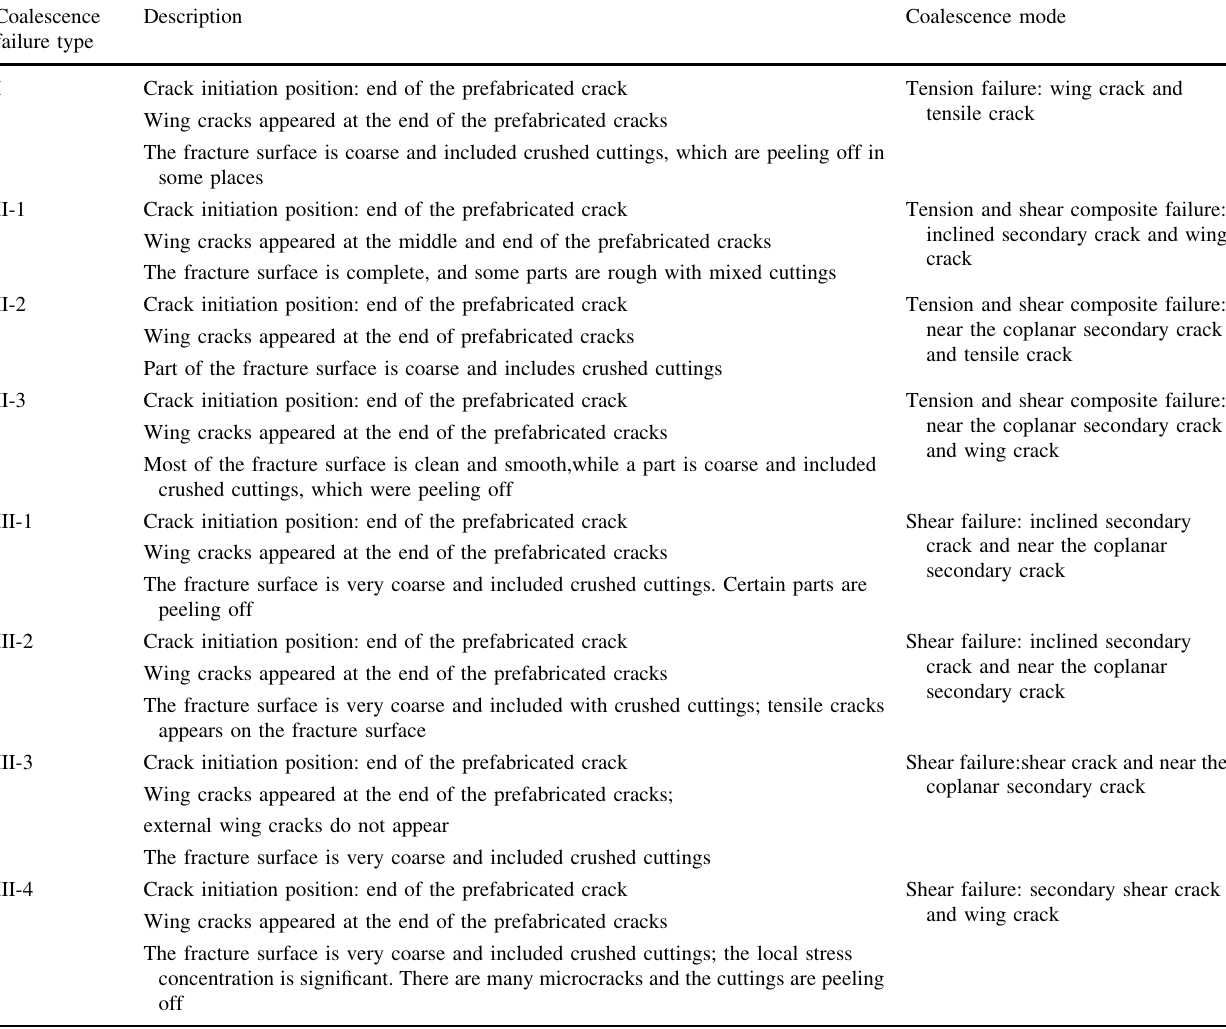
Table 3 Coalescence failure types of the cracked test